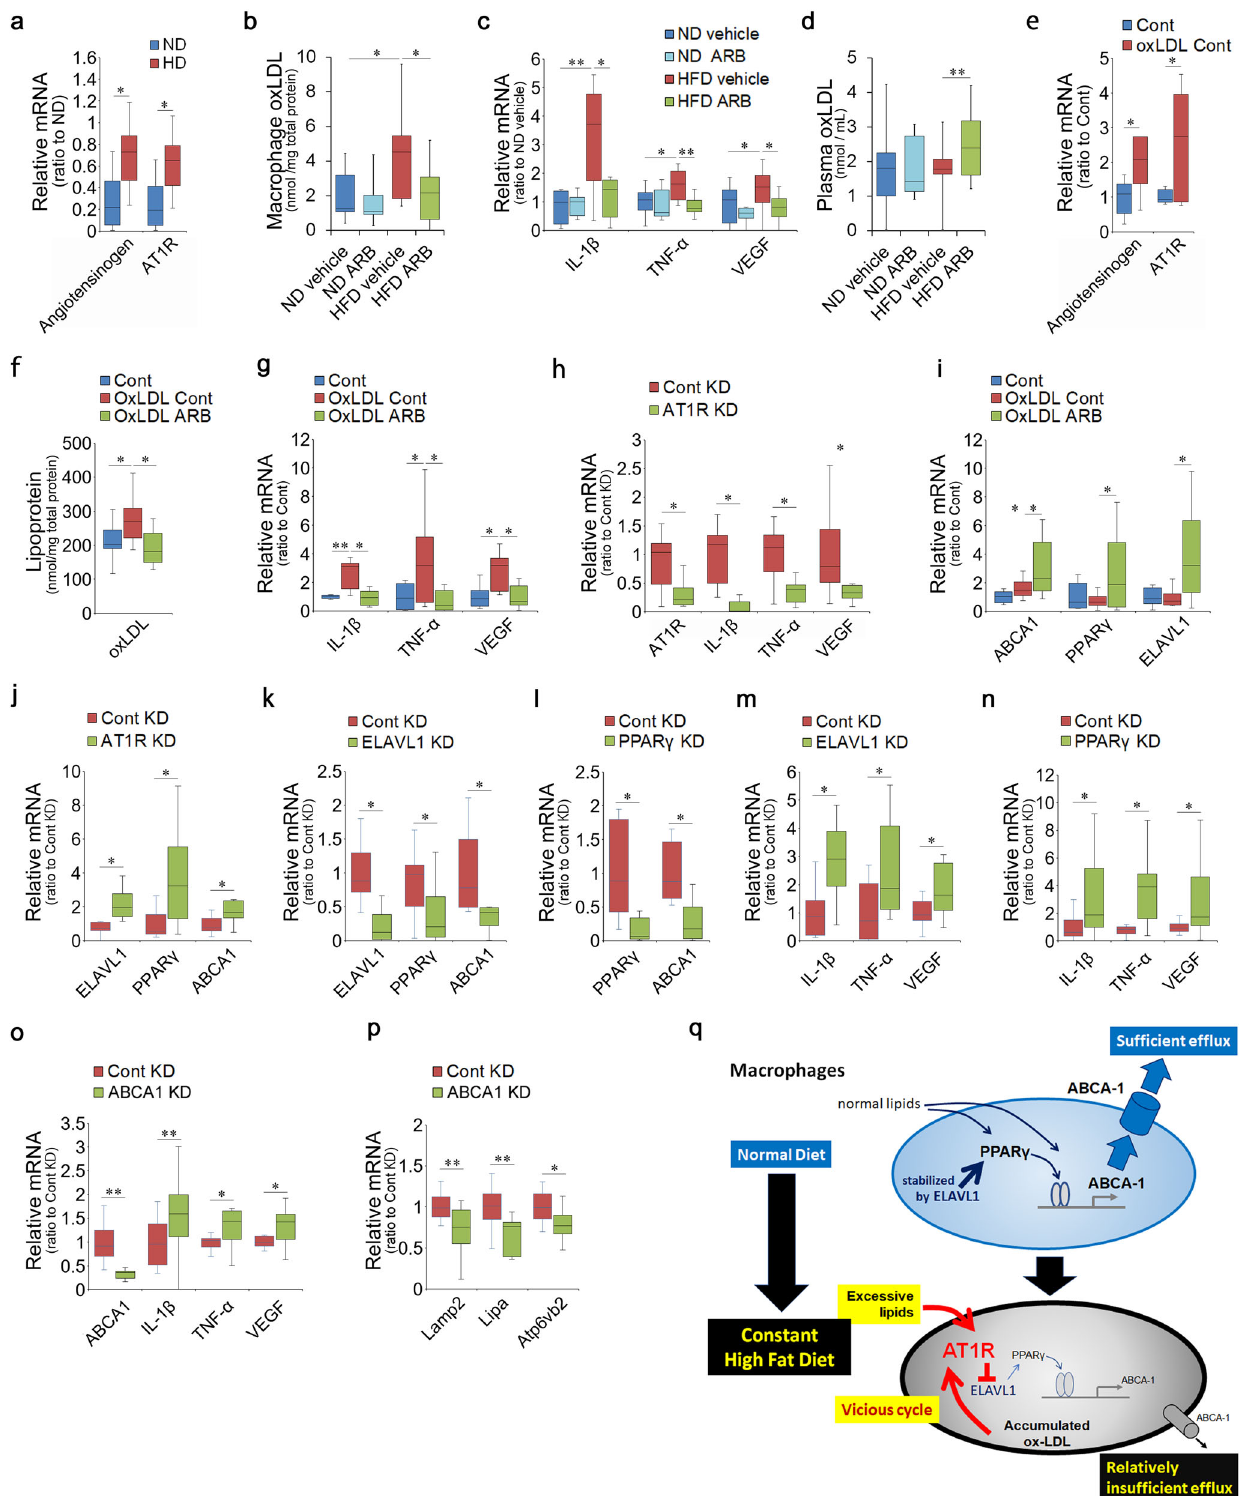
the current study developed undigested lysosomal deposits in the RPE, similar to the RPE of lysosome-de fi cient mice 51,52 . Reduc- tion in the expression of lysosome markers, NPC1 and LAMP2, and abnormal expression of an autophagy marker, FAK1, sup- ported the presence of lysosome disorganization in HFD